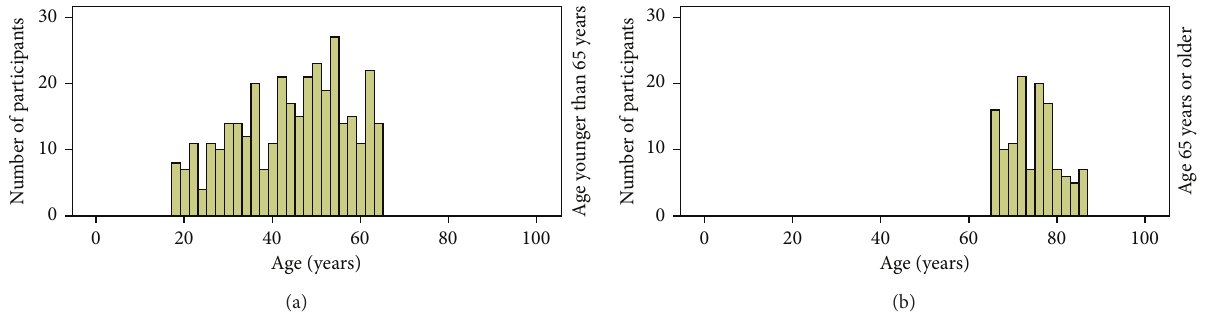
Figure 1: Age distribution of participants by group. Table 1: Description of